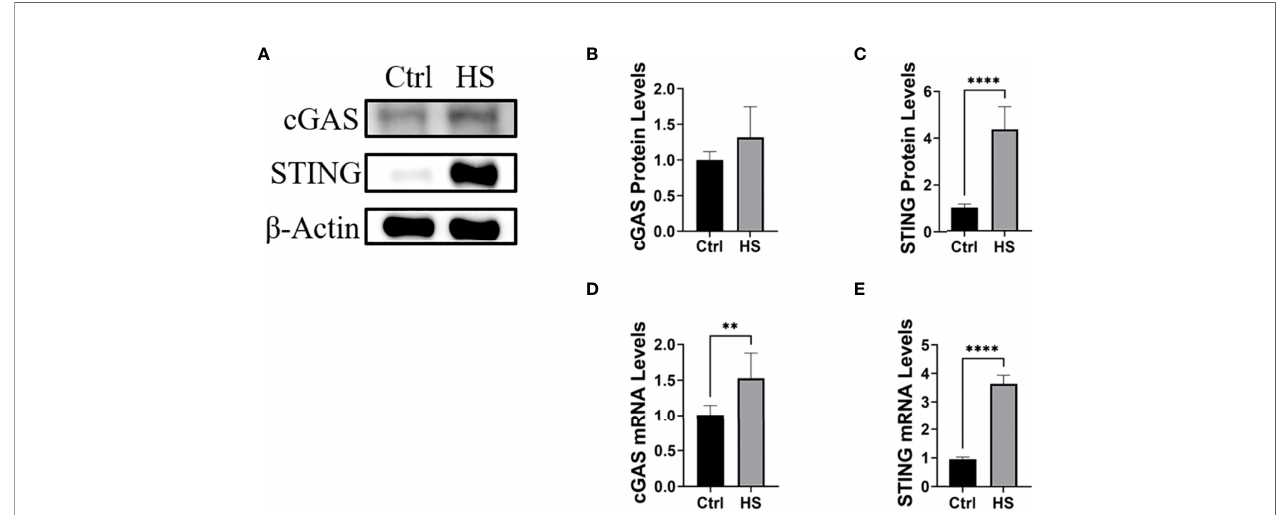
FIGURE 3 | Hyperosmotic stress induced the activation of the cGAS-STING pathway in HCE. (A-C) The protein levels of cGAS and STING in HCE treated with hyperosmotic stress for 24h. (D, E) The RT-PCR results of cGAS and STING in HCE treated with hyperosmotic stress for 24h. **P < 0.01, ****P <